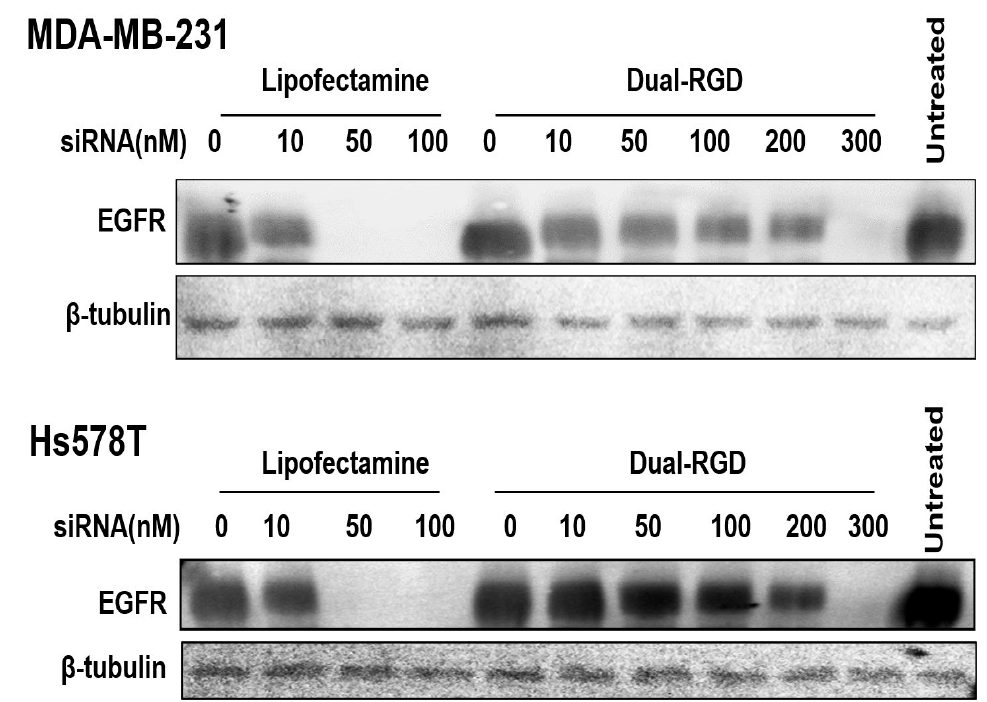
Figure 5. Detection of in vitro target gene knockdown. Integrin α v β 3 -expressing MDA-MB-231 and Hs578 T cell lines were treated with EGFR siRNA/dual-RGD at varying concentrations for 72 h. Lipofectamine was selected as a control. After treatment, the cell lysates were probed by Western blot.